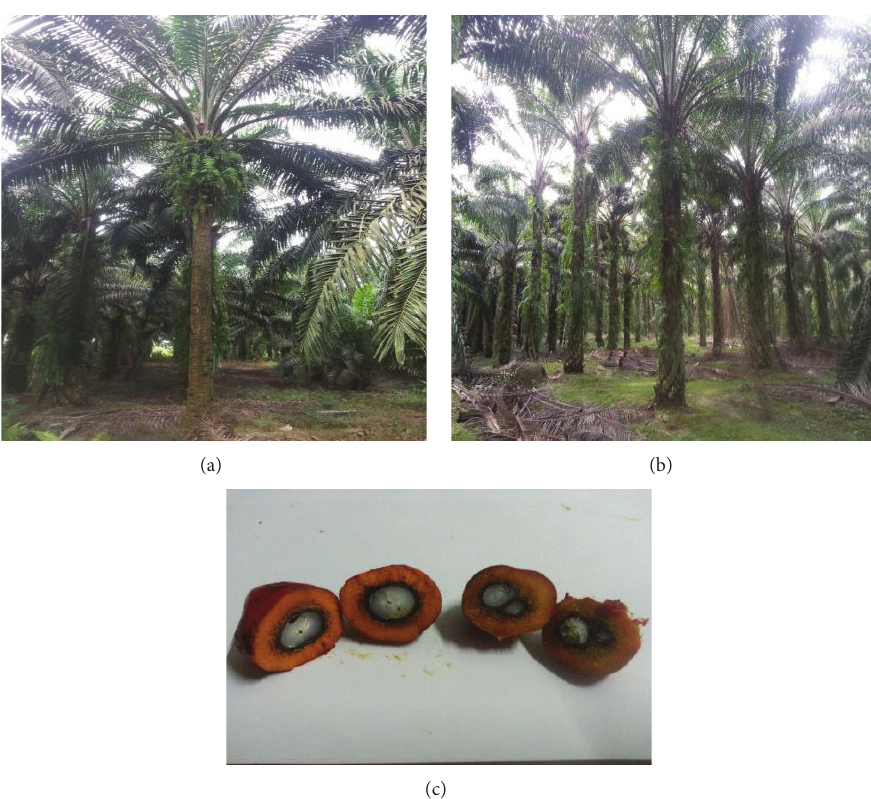
Figure 2: dura (a) and tenera (b) OPS aggregates taken from 10–15-year-old oil palm